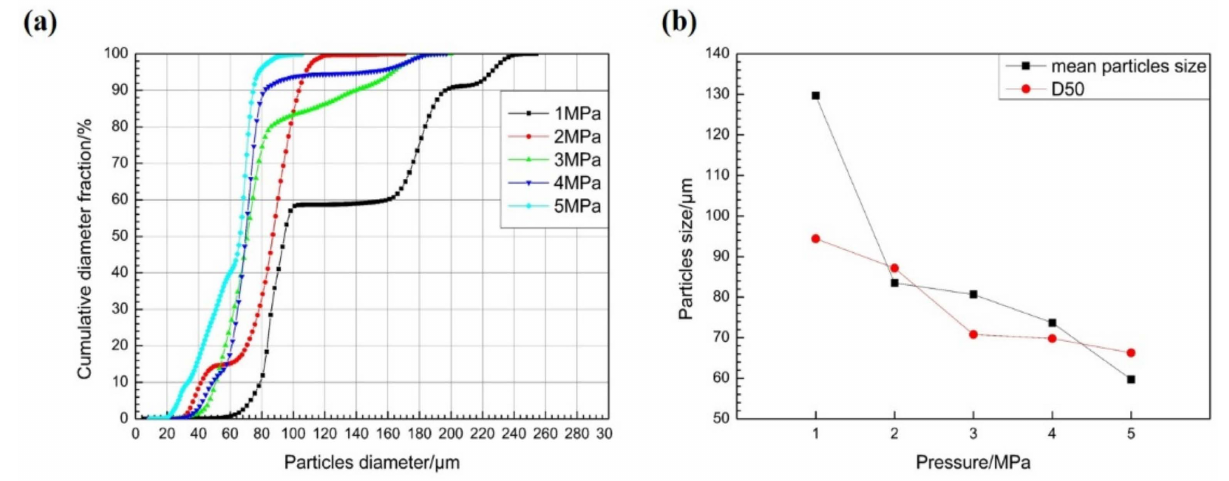
Figure 5. ( a ) Cumulative distribution curves of powder particle sizes at different atomization pressures. ( b ) Variation curves of average particle size and D50 value of powder with atomization